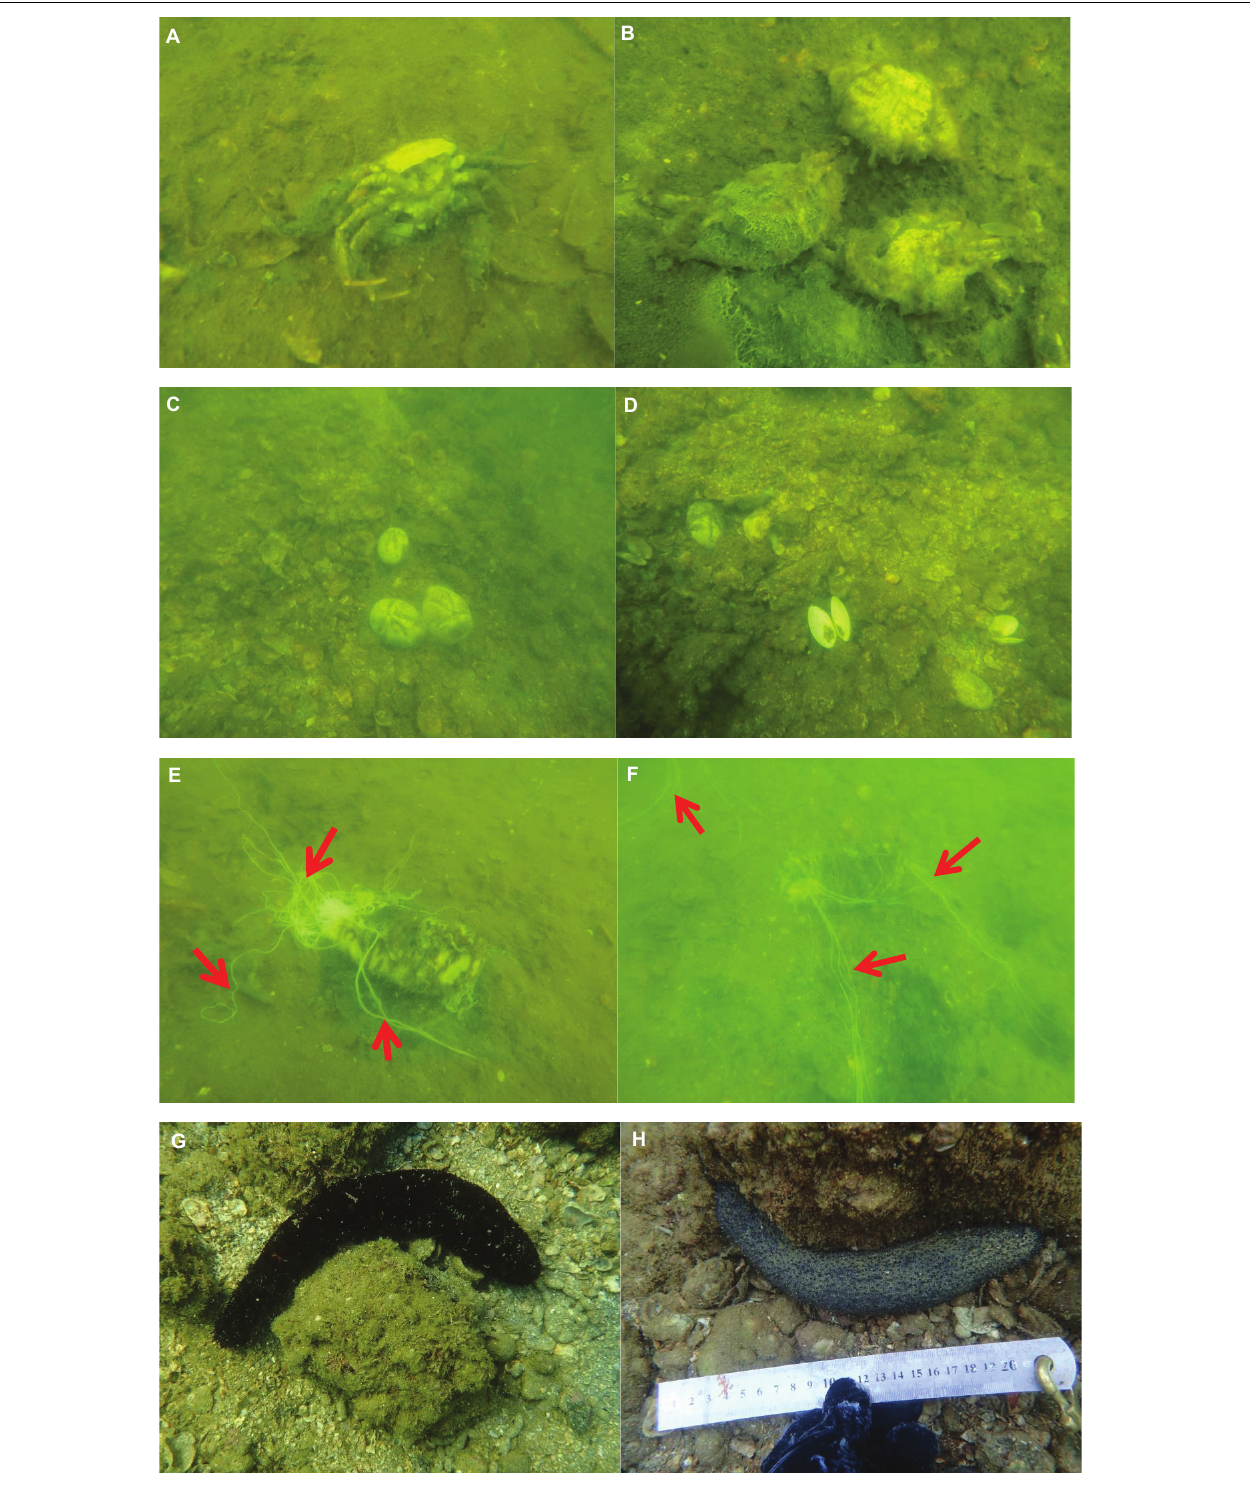
FIGURE 4 | Representative benthic invertebrates at S1 in summer 2017. Decaying corpses of crabs Charybdis japonica (A) and Portunus pelagicus (B) at DS 30–50 m; tests of the heart urchin Echinocardium spp. (C) and shells of the bivalve Asaphis violascens (D) at DS 30–50 m; dead Holothuria leucospilota at DS 20–40 m (E,F) , with arrows indicating Cuvierian tubules; live H. leucospilota at DS 0–10 m (G,H) .